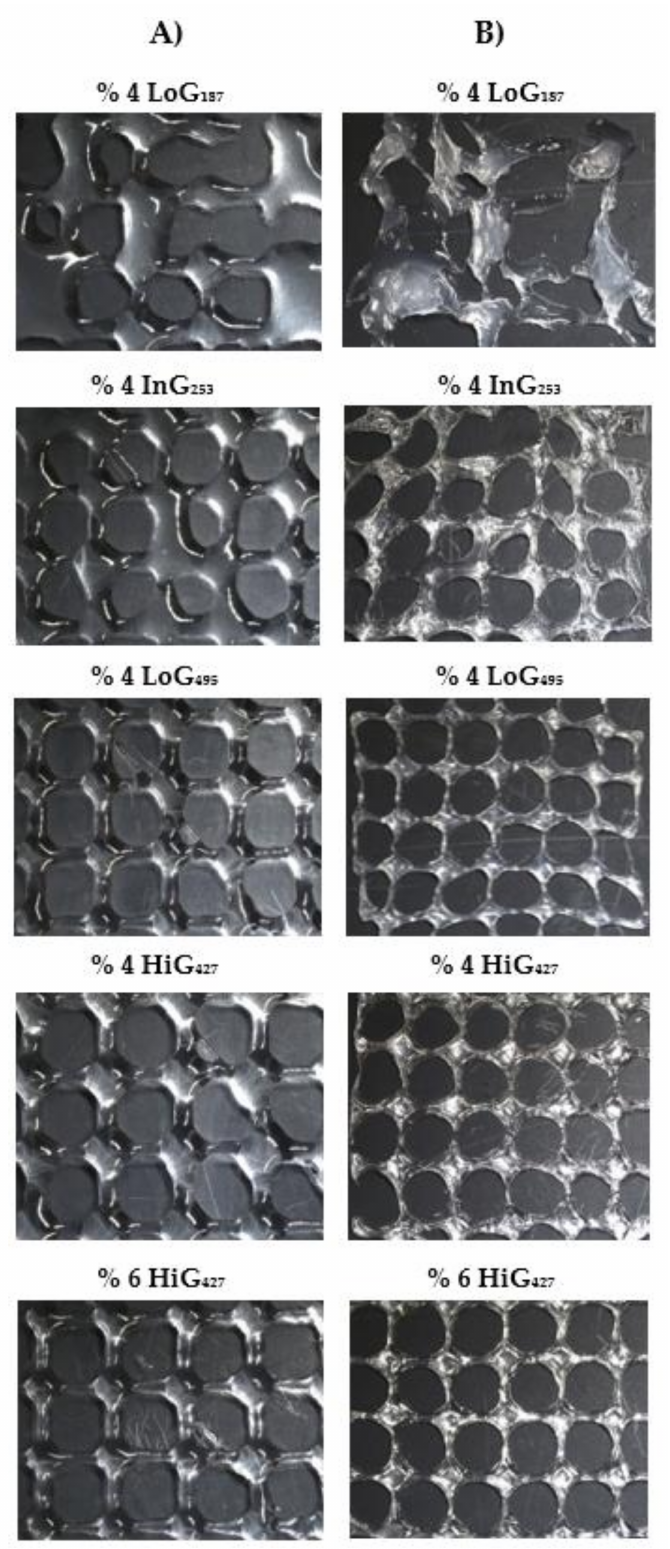
Figure 6. Different alginate imprint structures: ( A ) uncross-linked samples, ( B ) cross-linked samples (Magnification: 0.61 × , Needle inner diameter: 27